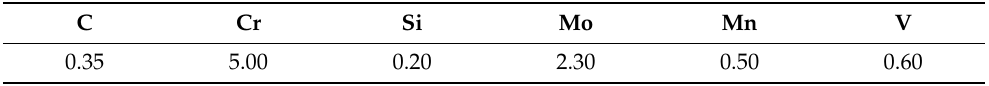
Table 3. Chemical composition of the X38CrMoV5-1 additive material (in wt.%). Fe bal.